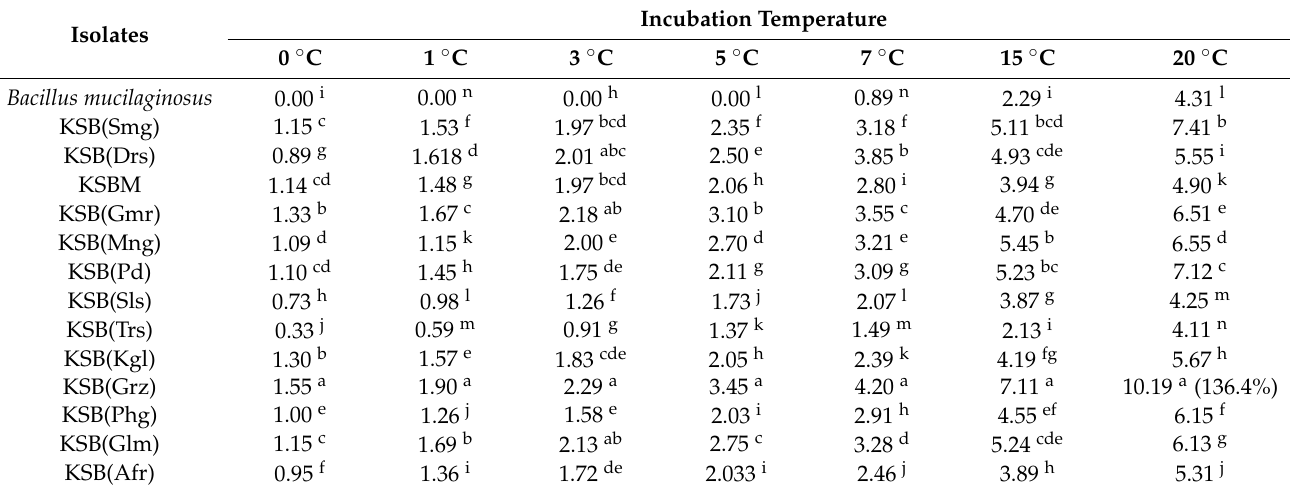
Table 2. Quantitative K solubilization ( µ g K/mL broth) potential of cold-tolerant bacterial isolates at different temperatures after 5 days of